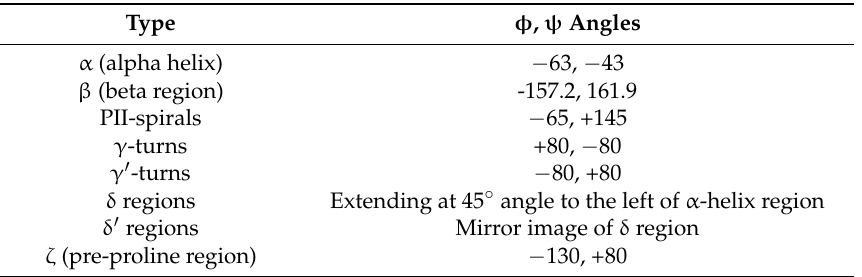
Table 1. Average Φ and Ψ angle values for various conformations on the Ramachandran plot (according to Hollingsworth and Karplus) 13